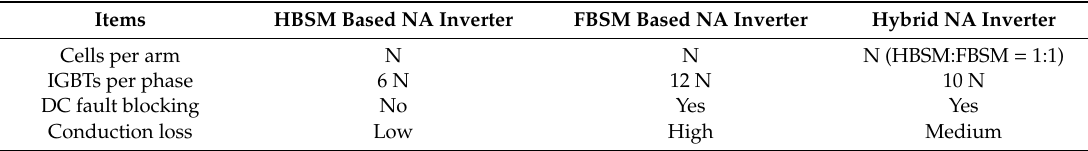
Table 1. Comparison between HBSM based NA inverter, FBSM based NA inverter, and hybrid NA inverter.